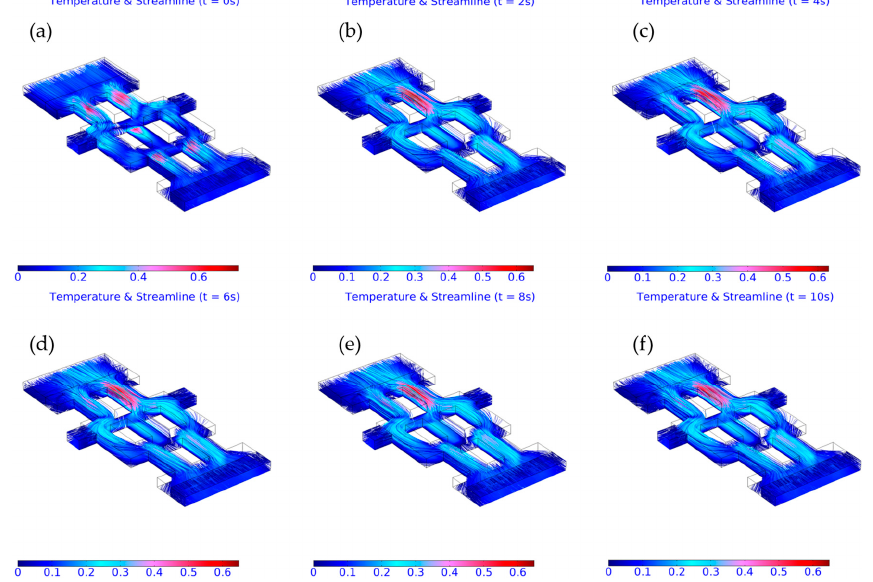
Figure 9. Distribution of velocity streamlines over the mixing chamber with obstacles at: ( a ) 0 s; ( b ) 2 s; ( c ) 4 s; ( d ) 6 s; ( e ) 8 s; and ( f ) 10 s. Different velocities are represented by different colors as shown in the color bar (in m s − 1 ).